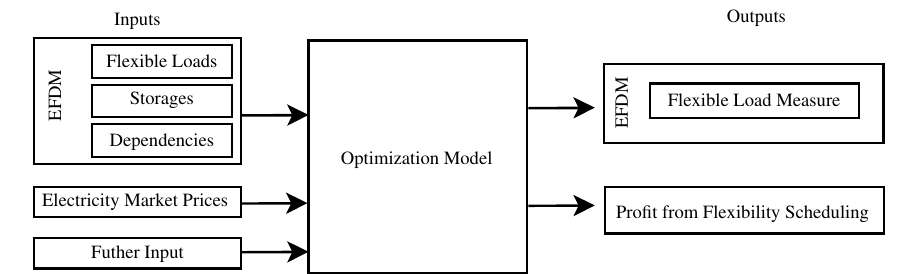
Fig. 1 Input and outputs of the optimization